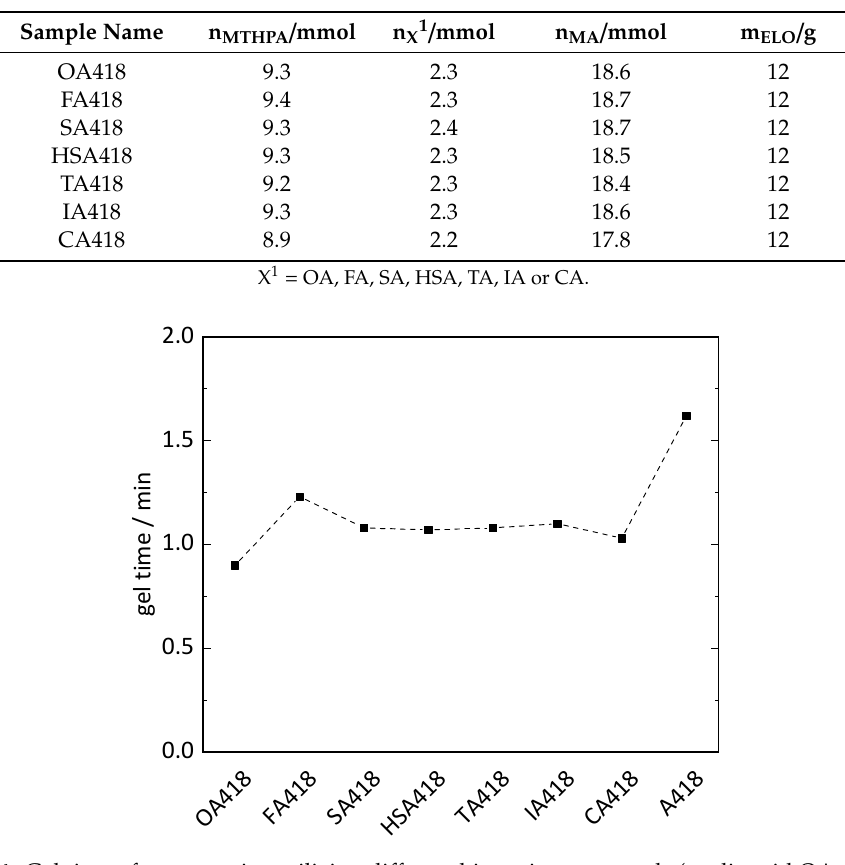
Figure 4. Gel time of epoxy resins utilizing di ff erent biogenic compounds (oxalic acid OA, fumaric acid FA, succinic acid SA, malic acid HSA, tartaric acid TA, itaconic acid IA and citric acid CA) in the hardener system (MA, MTHPA and X; X = biogenic compound).